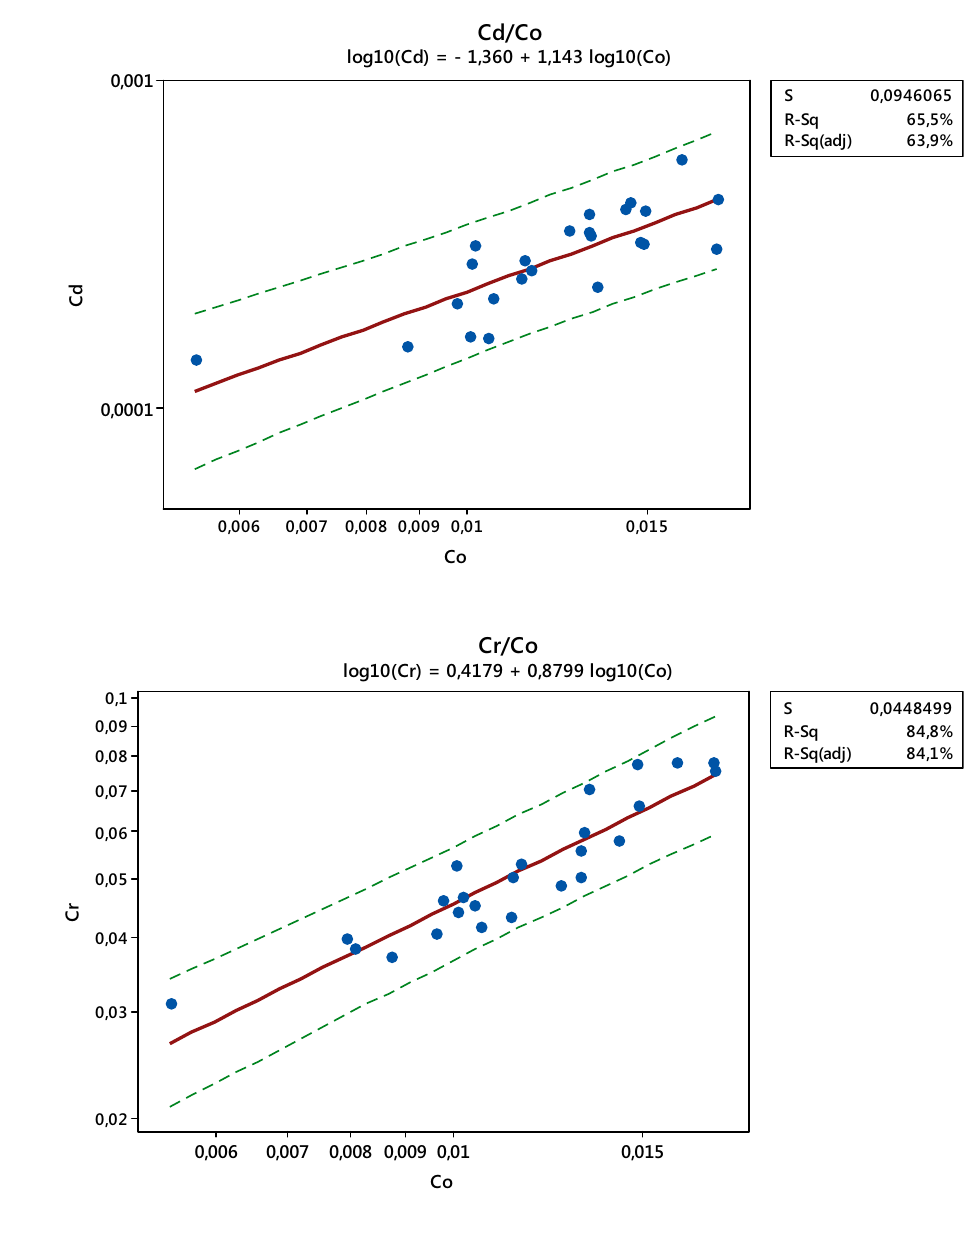
Fig. 2 Linear regression graph of cadmium background concentration determination ( R 2 = 65.5%)